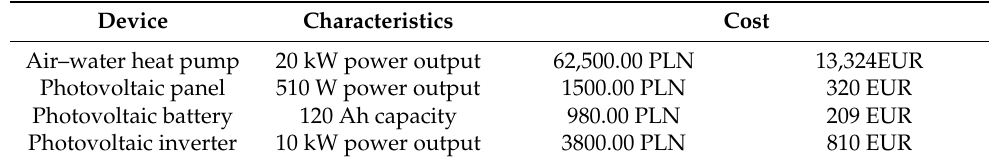
Table 3. Thermomodernization